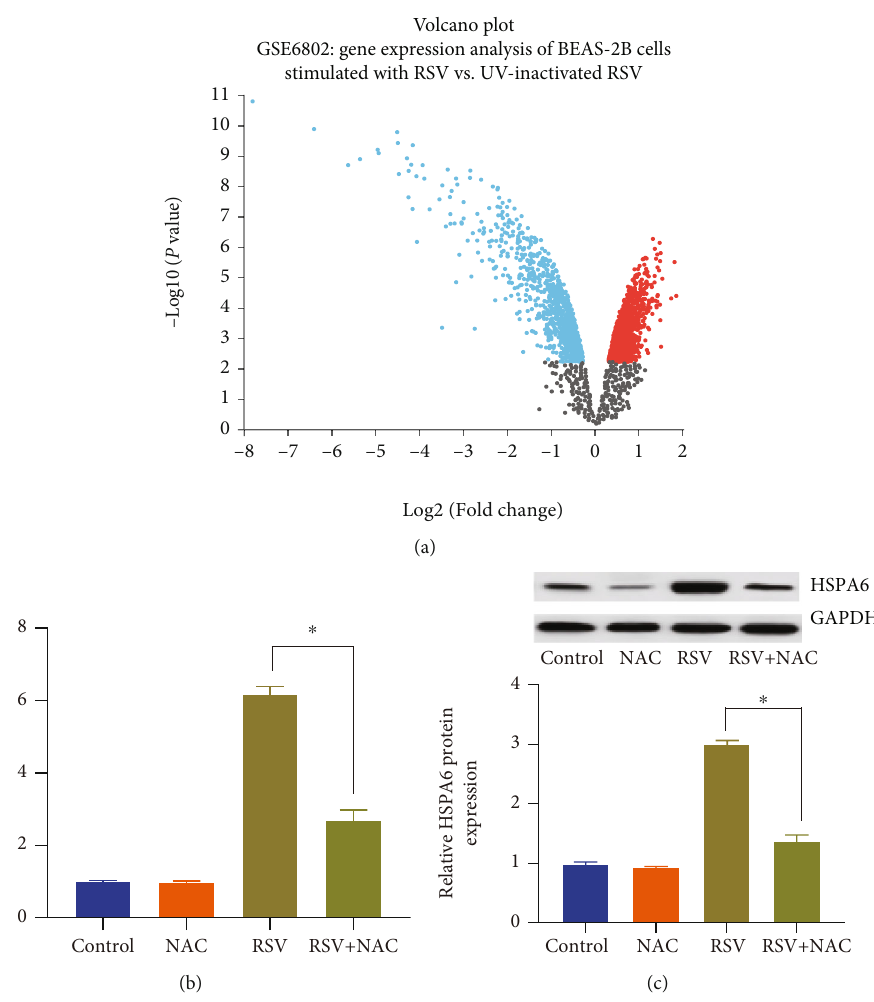
Figure 5: NAC treatment inhibits HSPA6 expression in RSV-infected BEAS-2B cells. (a), The volcano plot showing di ff erentially expressed genes between BEAS-2B cells stimulated with UV-inactivated RSV and BEAS-2B cells stimulated with the bronchial pathogen RSV. (b), Quantitative real-time PCR was performed to determine the mRNA expression of HSPA6 in RSV-infected BEAS-2B cells with or without NAC treatment. (c) Immunoblots of HSPA6 protein and their densitometric analysis in RSV-infected BEAS-2B cells with or without NAC treatment. ∗ indicates p < 0 : 01